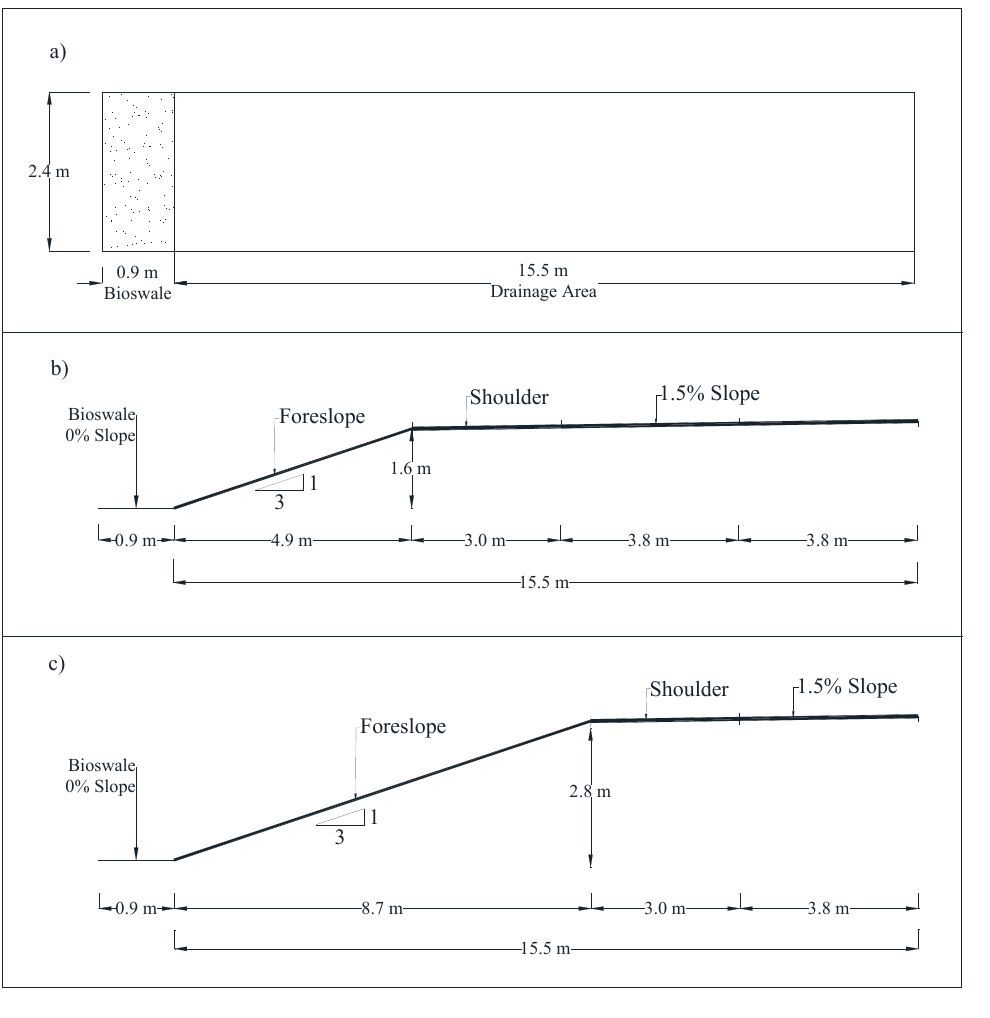
Figure 2. ( a ) Plan view of field-test layout; potential cross-section layout of ( b ) one-lane highway, ( c ) two-lane highway.